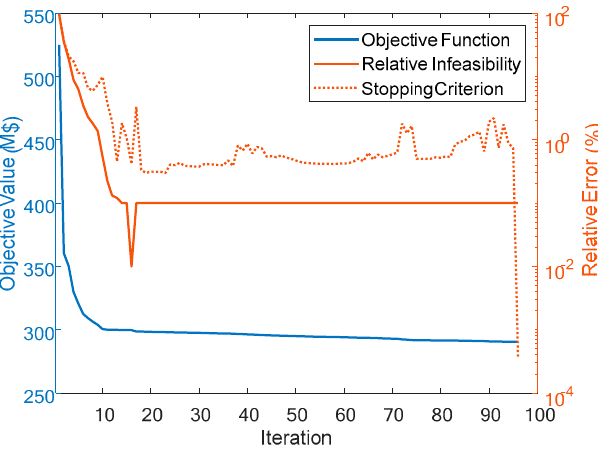
Figure 3. Iteration process for the optimal run of T = 1.